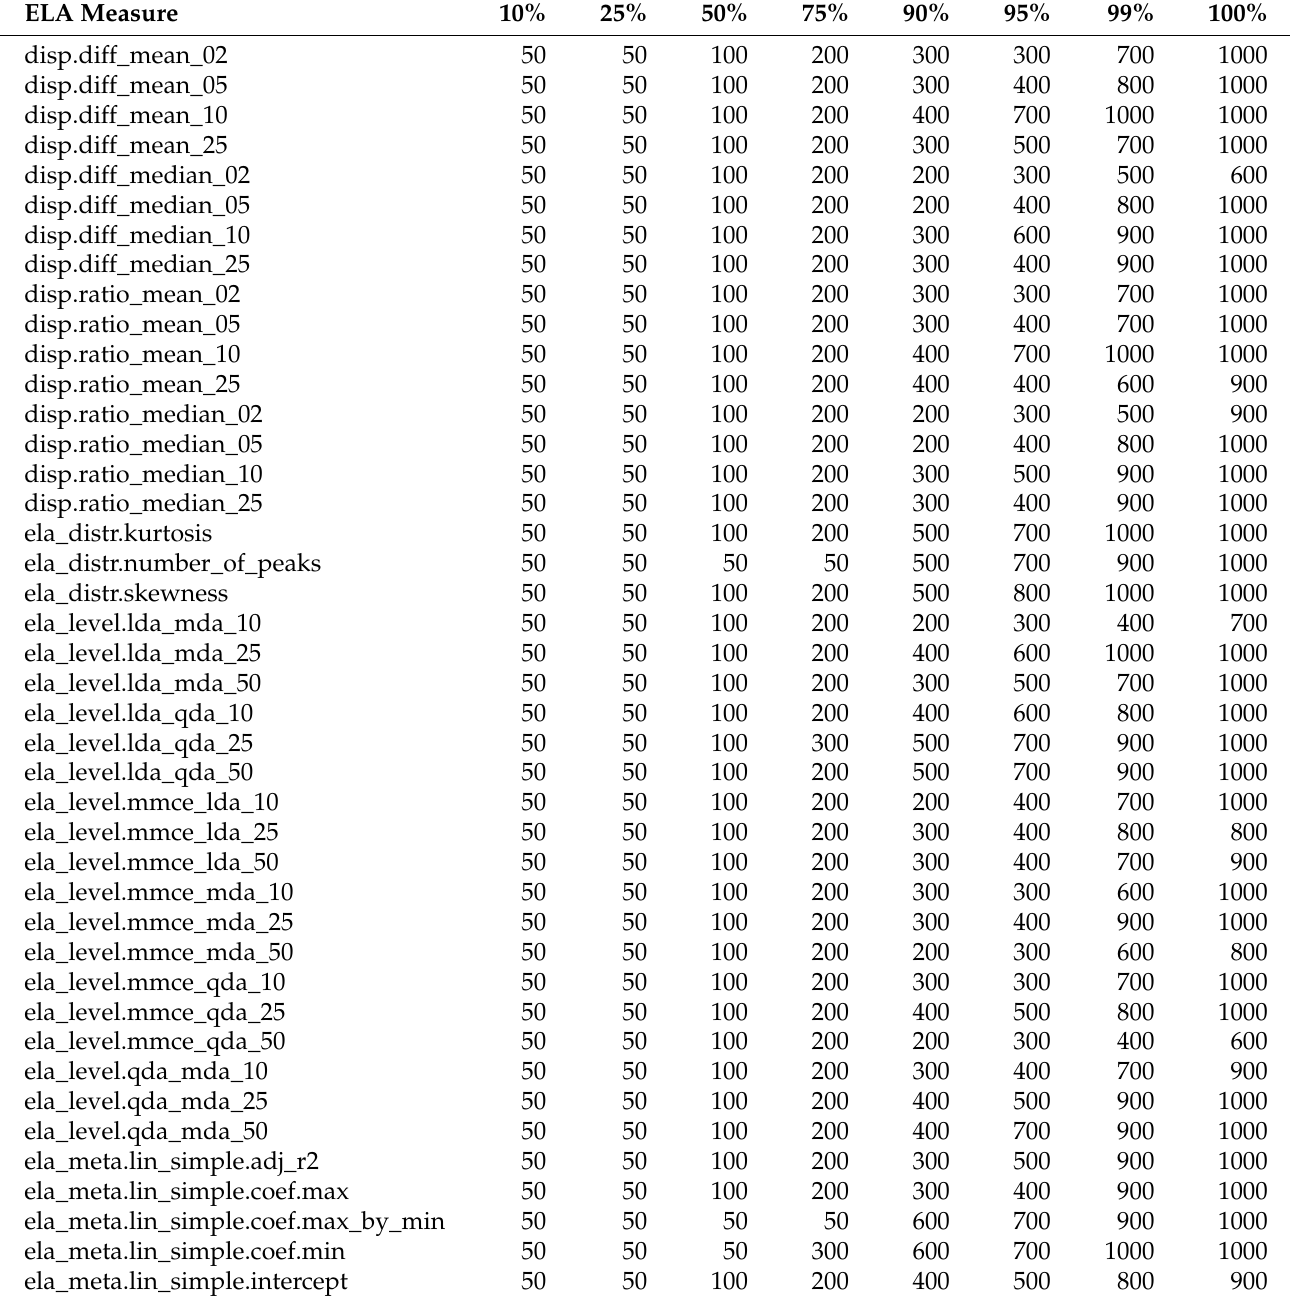
Table 1. Percentiles for the point of robustness for all the investigated benchmark functions. The entries in the table represent sample sizes multiplied by D , where D =